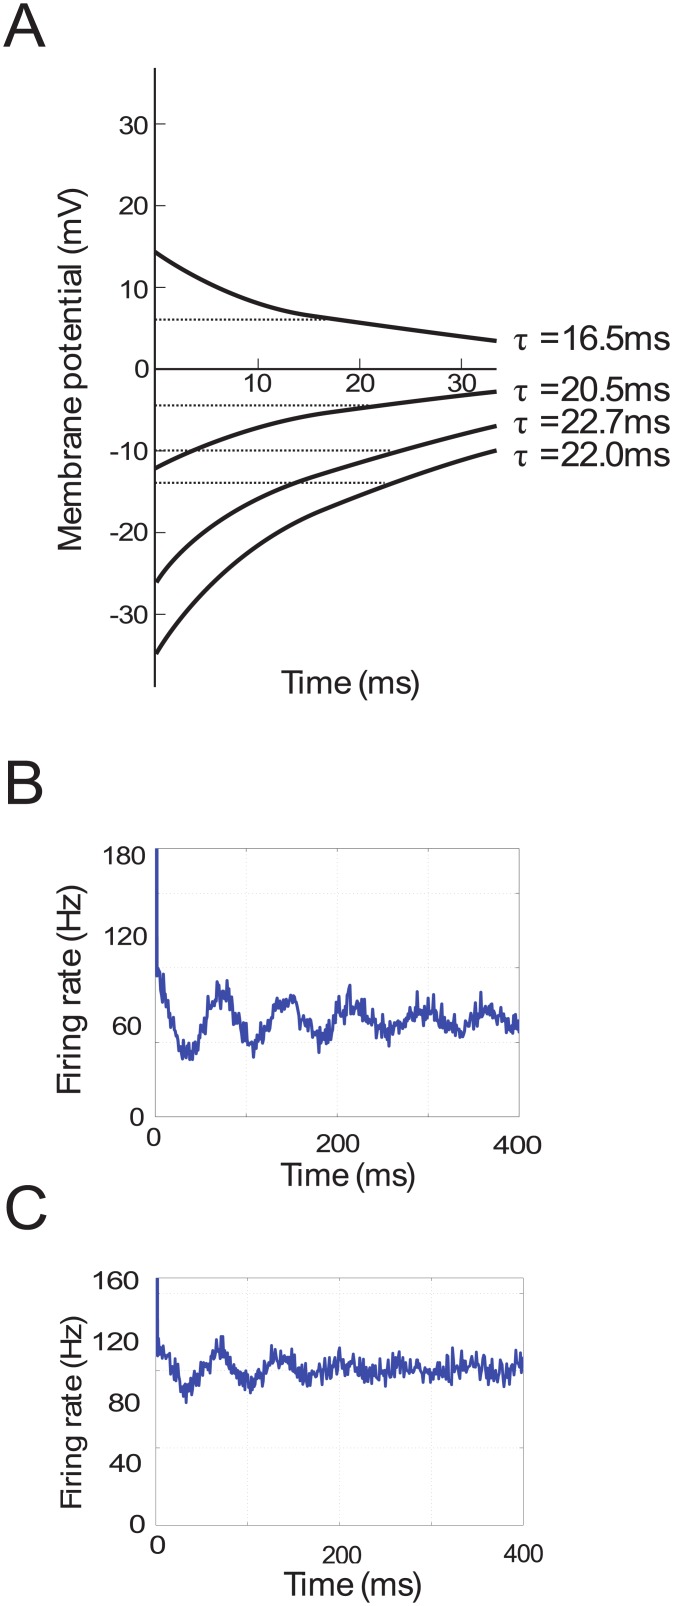
Experimental data used to estimate parameters of the models.A) Changes in the membrane potential of a GPe neuron following current injections. Data taken from Kita and Kitai [61] (Fig 2, Panel A). Dashed lines indicate V
0
e
−1. B, C) Simulated auto-correlograms of STN and GPe neurons.